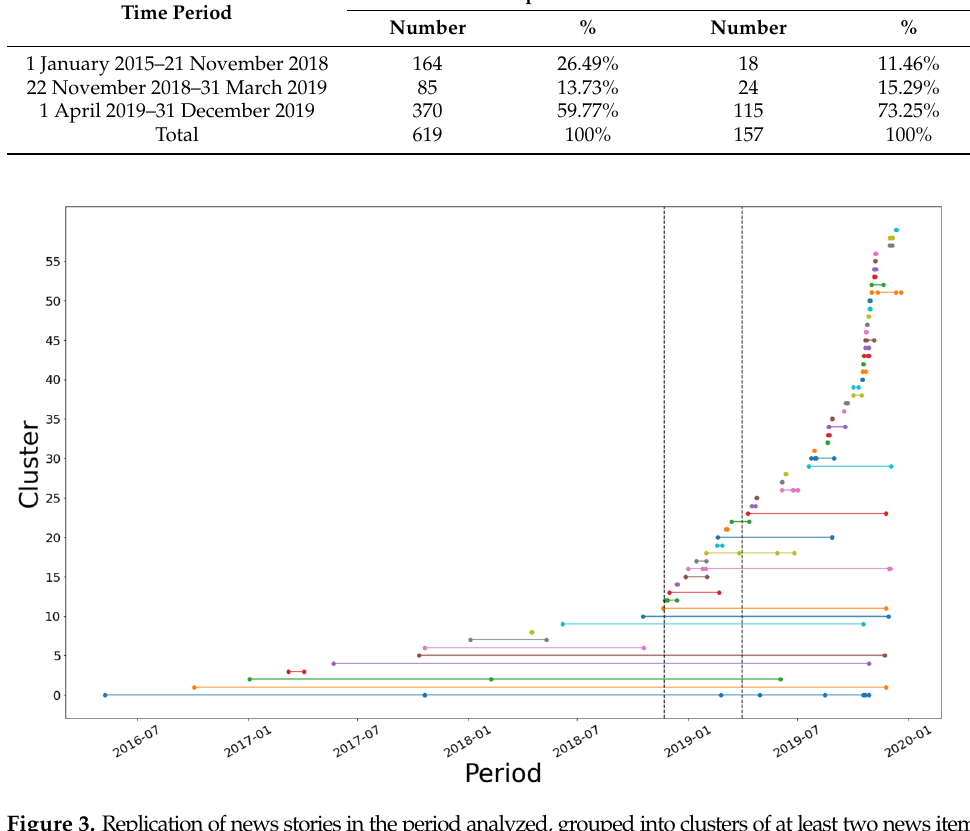
Figure 3. Replication of news stories in the period analyzed, grouped into clusters of at least two news items.